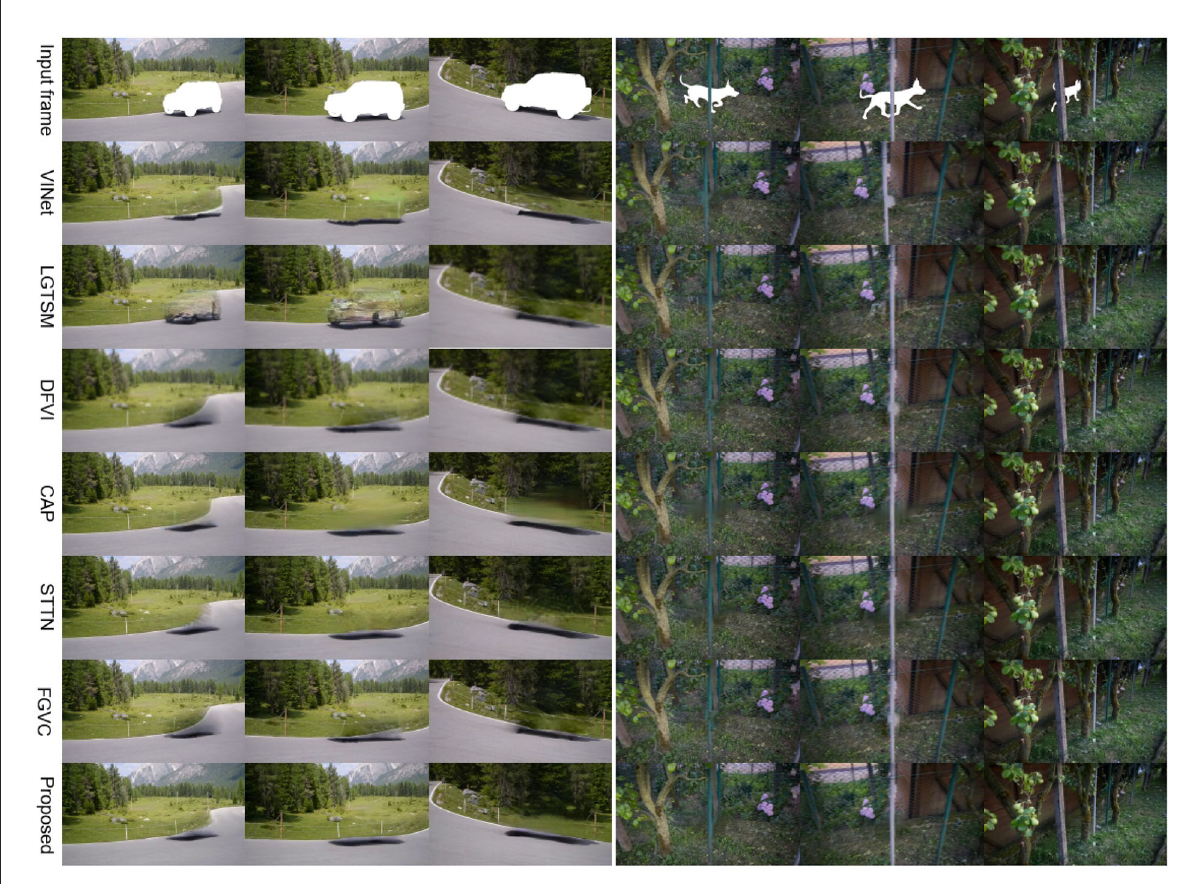
FIGURE4 Qualitative comparison with other methods for dynamic